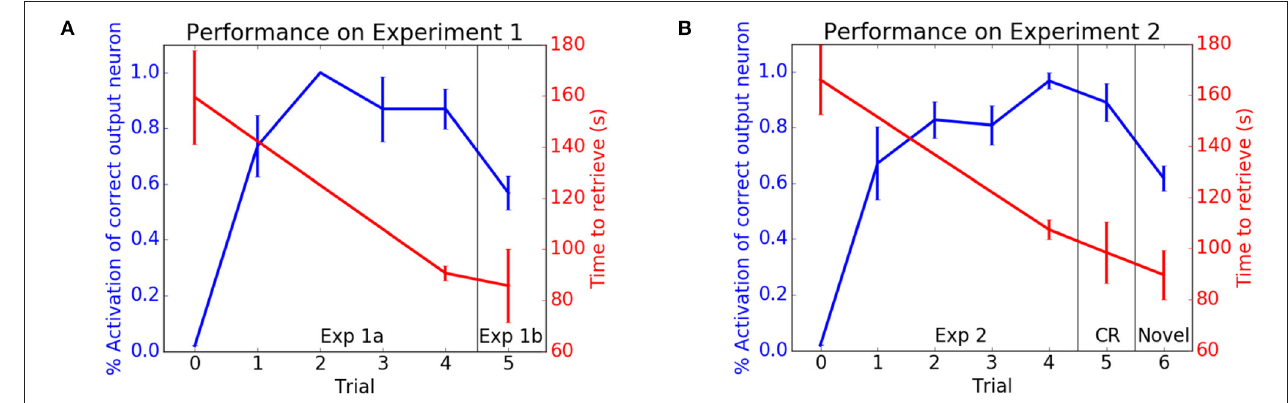
FIGURE 4 | Performance on neurobotic schema experiments. The blue lines show the activation of the correct location neuron for a cued object. The red lines show the retrieval times. (A) Experiment 1. Performance in the classroom schema (Exp 1a) and retrieval of novel object (Exp 1b). (B) Experiment 2. Performance in the breakroom schema. CR denotes performance when returned to classroom. Novel denotes retrieval of a novel object. Adapted from Hwu et al. (2020).